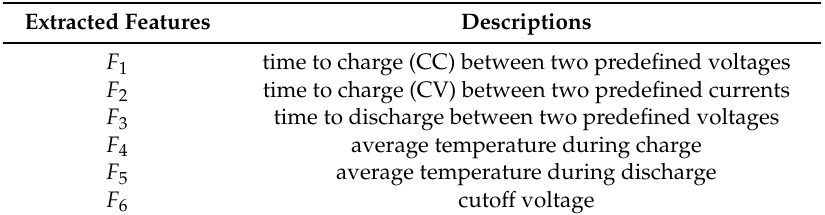
Table 1. Six extracted